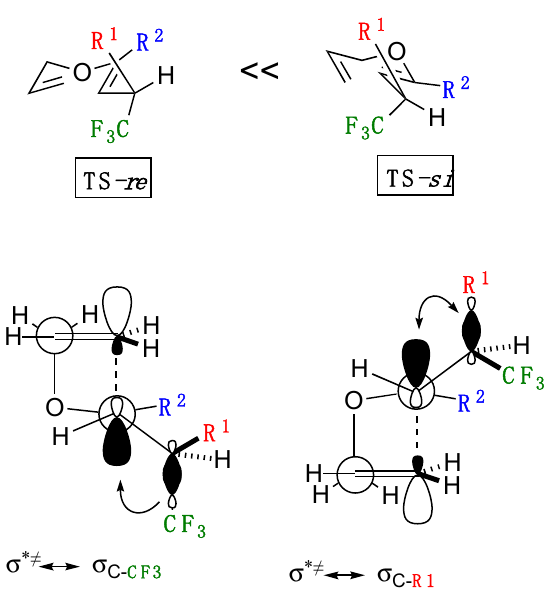
Figure 1. Cieplak model for interpretation of the diastereoselectivity obtained.